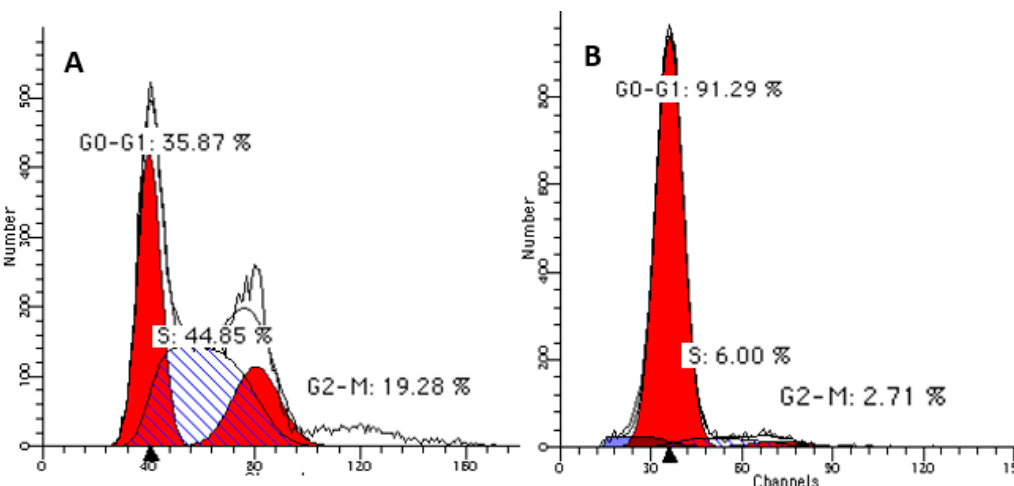
Figure 3. Cell cycle histograms of Leishmania infantum promastigotes exposed to Lavandula luisieri essential oil. L. infantum promastigotas were incubated at 26 °C for 24 h in the absence ( A ) or presence ( B ) of L. luisieri essential oil at IC 50 concentrations. Propidium iodide staining was performed and samples were analyzed by flow cytometry. Table 3. Flow cytometry analysis of Leishmania infantum promastigotes treated with Lavandula luisieri essential oil, showing the percentage of propidium iodide (PI) and annexin-V positive